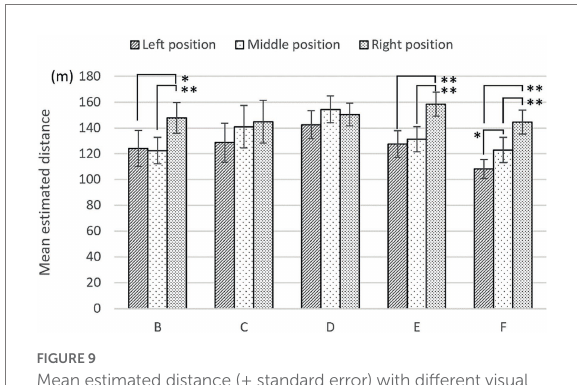
** Significance ( p < 0.01).